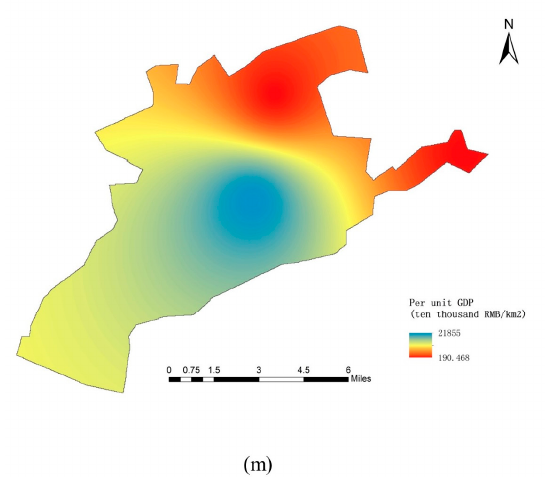
Figure 4. Spatial distribution data in study area: ( a ) Annual rainfall; ( b ) Elevation; ( c ) Slope; ( d ) River density; ( e ) Distance to river; ( f ) Pipe density; ( g ) Soil; ( h ) Land cover; ( i ) Curve Number (CN); ( j ) soil water retention (SWR); ( k ) Road density; ( l ) Population density; ( m ) Per unit gross domestic product (GDP).